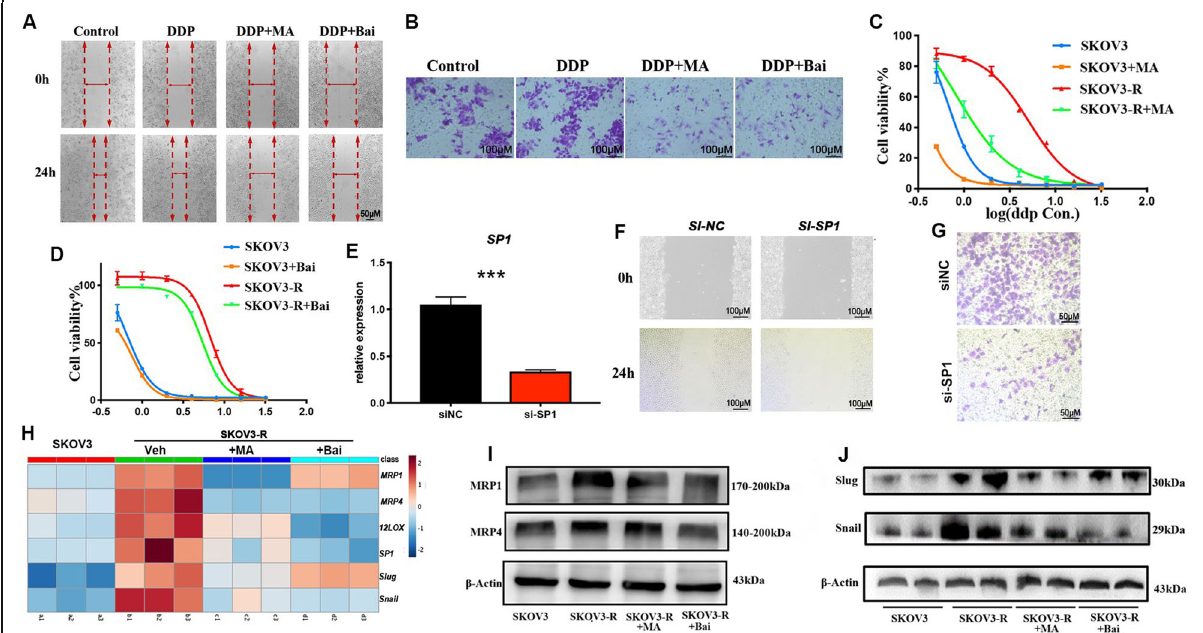
Fig. 3 Inhibition of SP1 or 12LOX dampens metastasis and DDP-resistance of SKOV3-R cells in vitro. a-d After incubation with Bai (20 μ M) or MA (30 nM) for 24 h, migration and invasion were tested by wound-healing assays ( a ) and transwell assays ( b ); the cell viability percentages were measured by CCK-8 assay ( c, d ). siNC denoted SP1 siRNA negative control, si-SP1 denoted SP1 siRNA. e-g After SKOV3-R cells were treated with these siRNAs, the gene expression levels of SP1 was evaluated by qPCR ( e ) and migration and invasion were tested by wound-healing assays ( f ) and transwell assays ( g ). h-j After administration with Bai (20 μ M) or MA (30 nM) for 24 h, the heatmap for gene expression of MRP1 , MRP4 , SP1 , 12LOX , Slug and Snail ( h ) and the protein level of MRP1, MRP4, Slug and Snail were evaluated by western blotting ( i,j ). Data are expressed as mean ± SEM of 4 independent experiments. *** P <